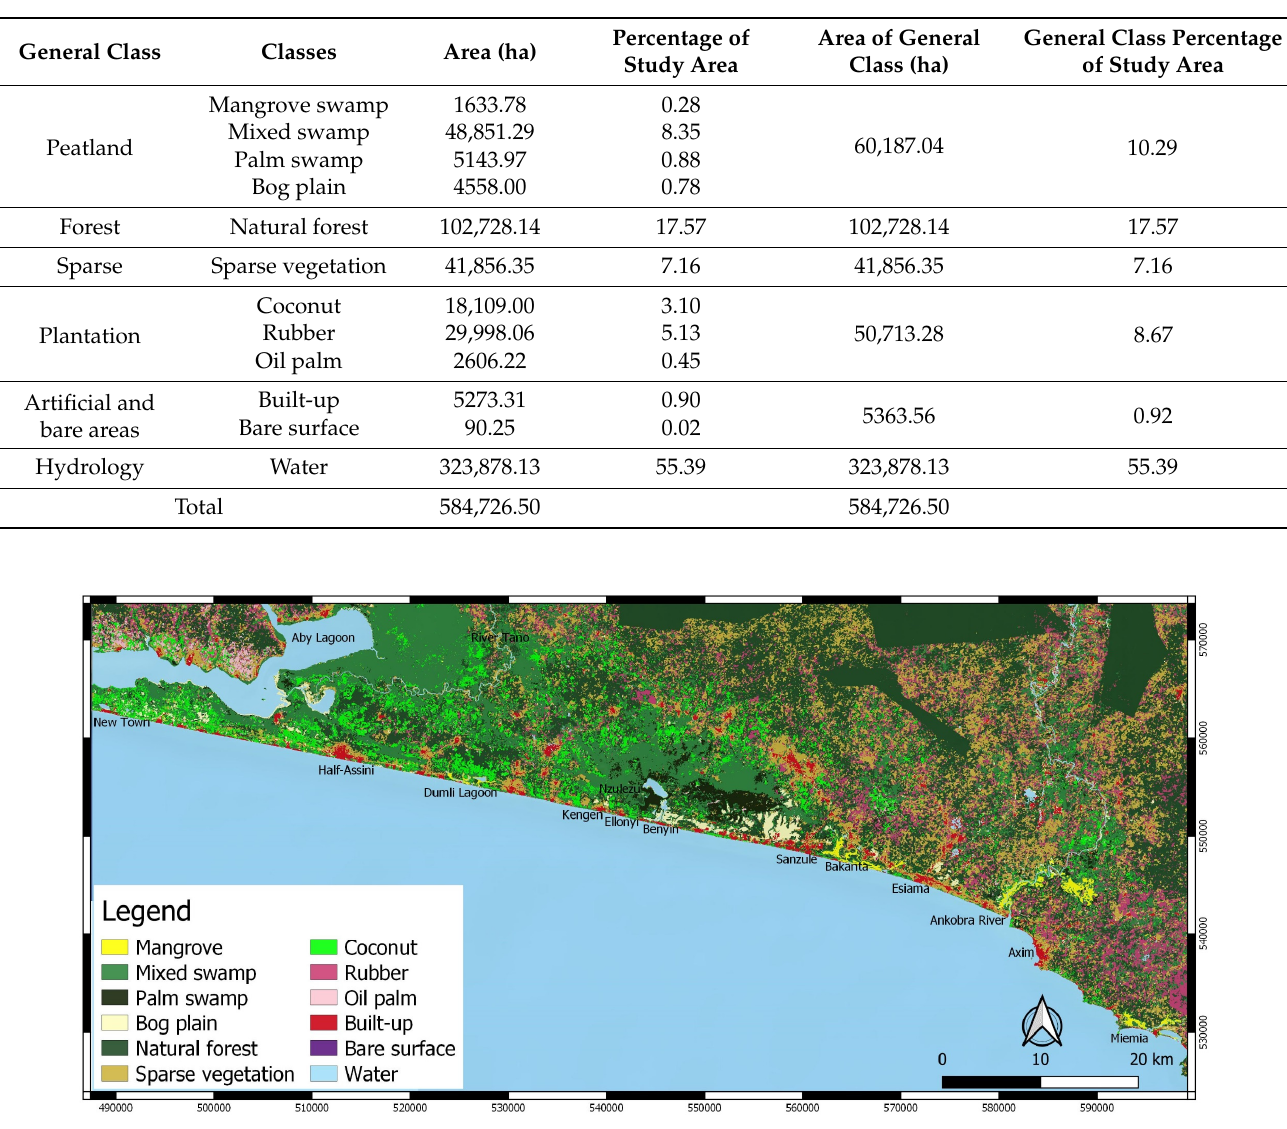
Table 8. Land cover class areas in Greater Amanzule classification.